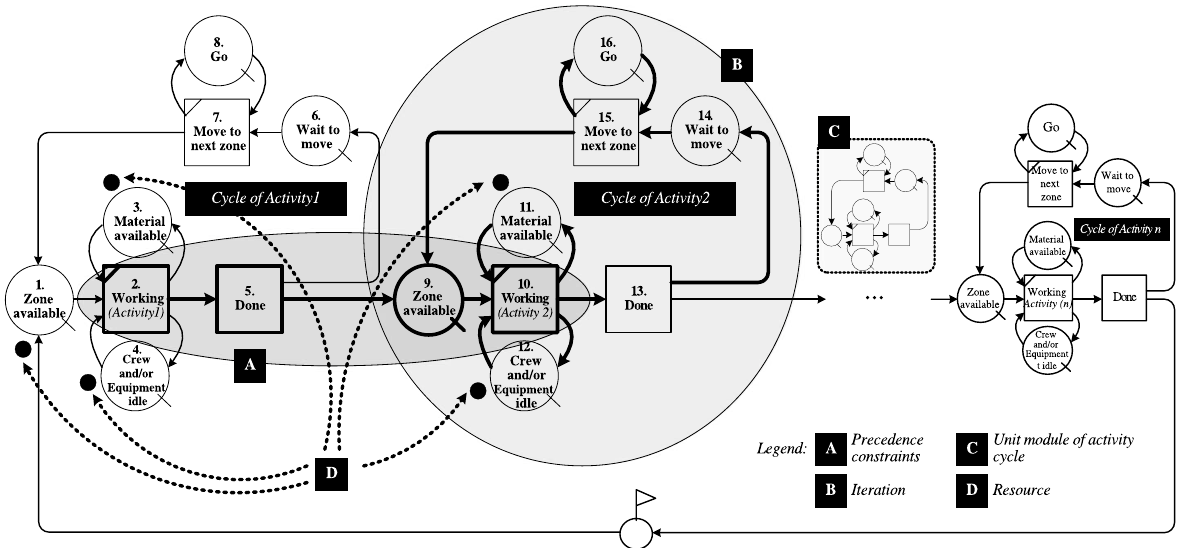
Fig. 3. Space zoning concept-based scheduling